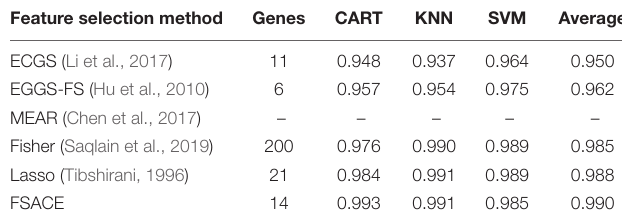
TABLE 8 | Classification accuracy of Robert using six different feature selection algorithms.